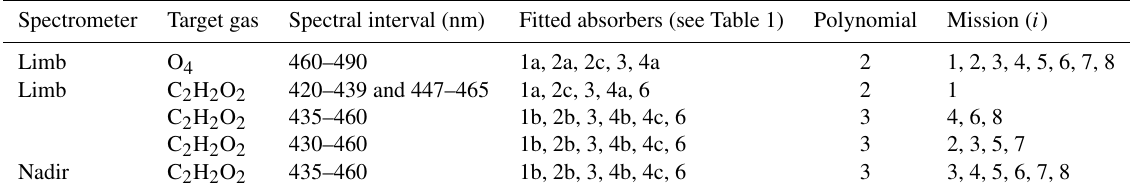
Table 2. Details of the DOAS spectral analysis for the target trace